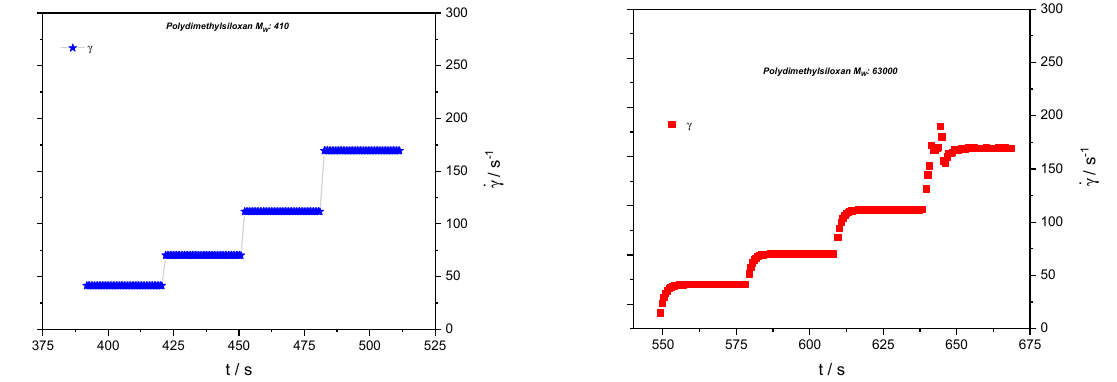
Figure 2. Shear-rate step experiments for the two samples with shear rates subsequently applied in the rheo-NMR experiments.